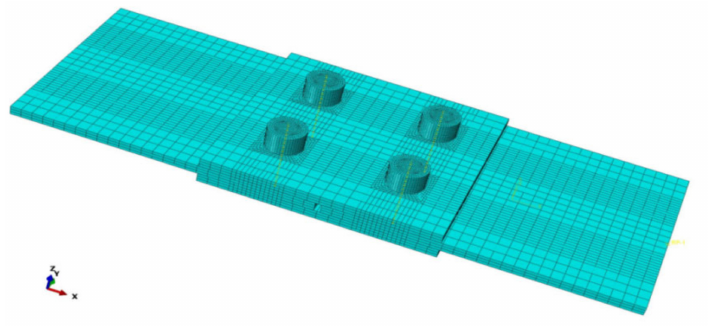
Figure 14. Finite element